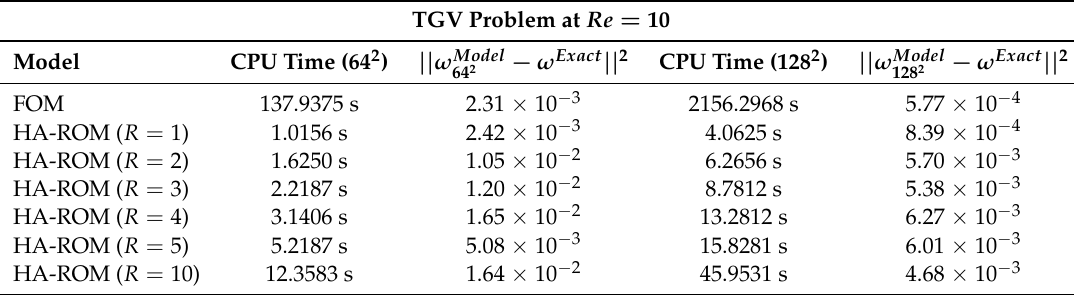
Table 2. A quantitative analysis and predictive performance of the proposed HA-ROM framework for the decaying Taylor-Green vortex (TGV) problem. Note that the error increases with increasing R for this problem because the first mode fully represents the TGV dynamics as shown in Figure